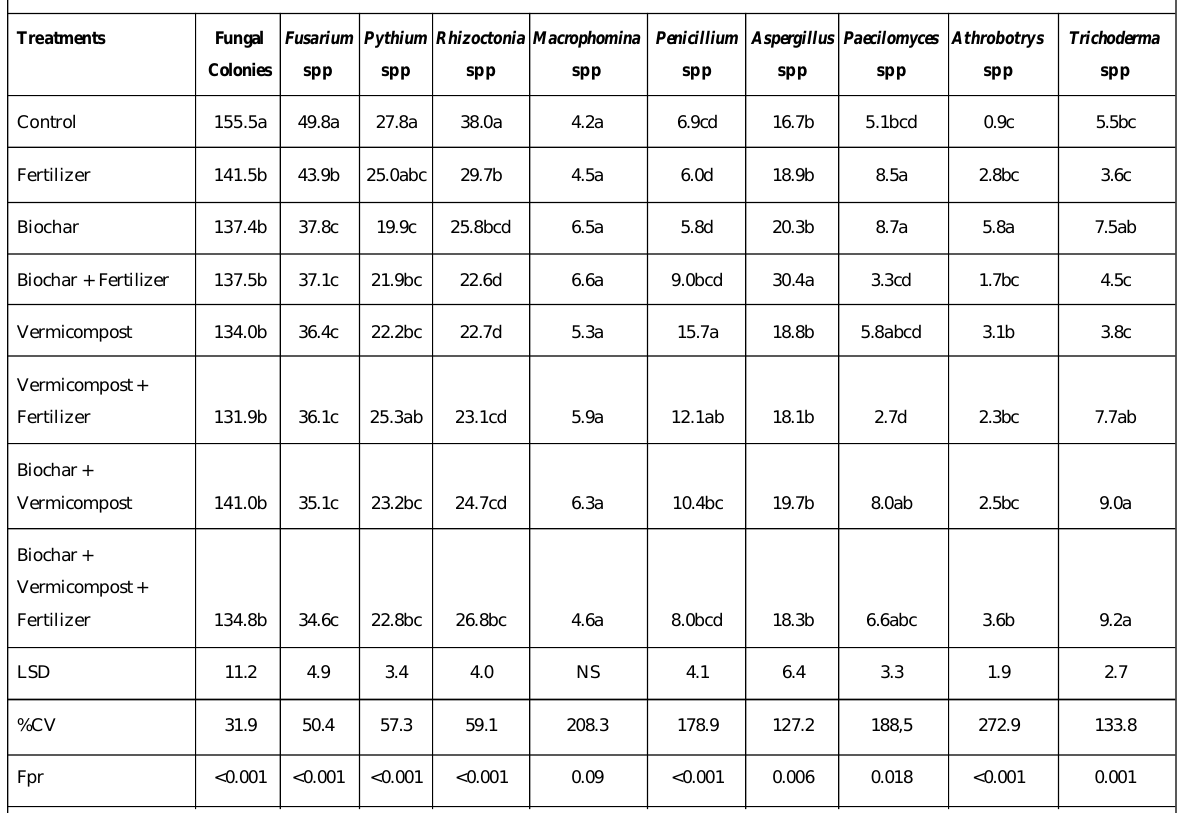
Table 15: The residual effect of biochar and vermicompost on fungal populations ( × 10 3 CFU/g soil) at harvest of common bean in the short rains season of